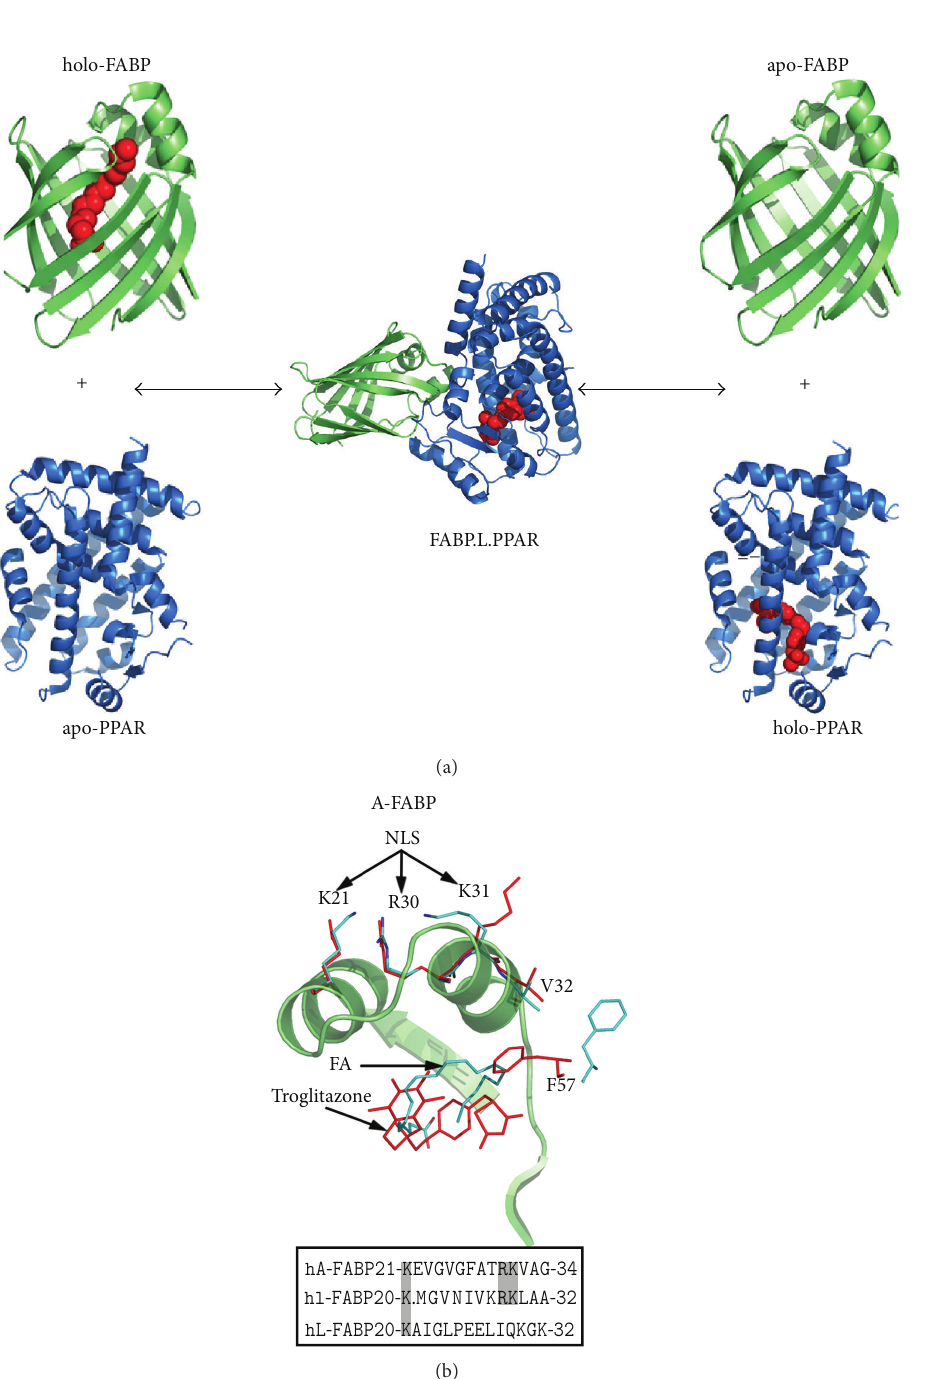
Figure 7: (a) The conformational nuclear localisation signal formed in A-FABP upon binding of an activating ligand. The portal region of A-FABP is shown in ribbon representation in complex with an activator ligand troglitazone (red; PDB code: 2QM9.pdb) and in complex with a non-activator ligand, arachidonic acid (cyan; PDB code: 1ADL.pdb). The side chains of the NLS residues (Lys 21 , Arg 30 , Lys 31 ) and cavity lid residue (Phe 57 ) are shown in sticks representation. Below , sequence alignment of the NLS region of human A-FABP, with human I- and L-FABP. NLS residues are highlighted in bold on a grey background. (b) Putative mechanism for the transfer of ligands from FABPs to PPAR